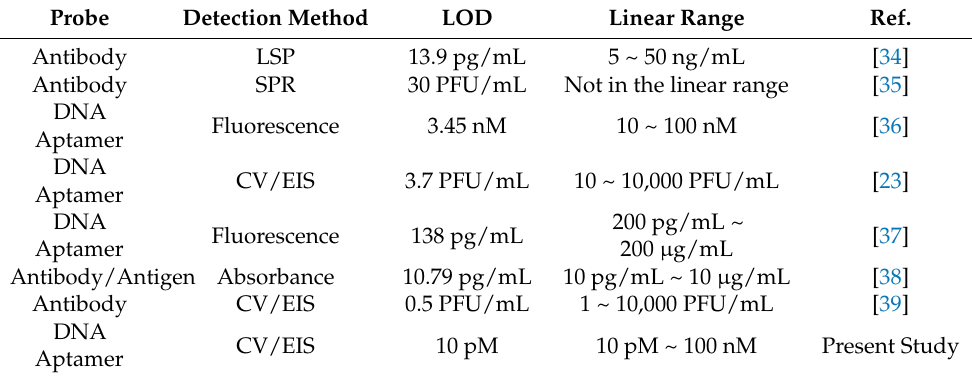
Table 2. Comparison of this study with other studies for H1N1